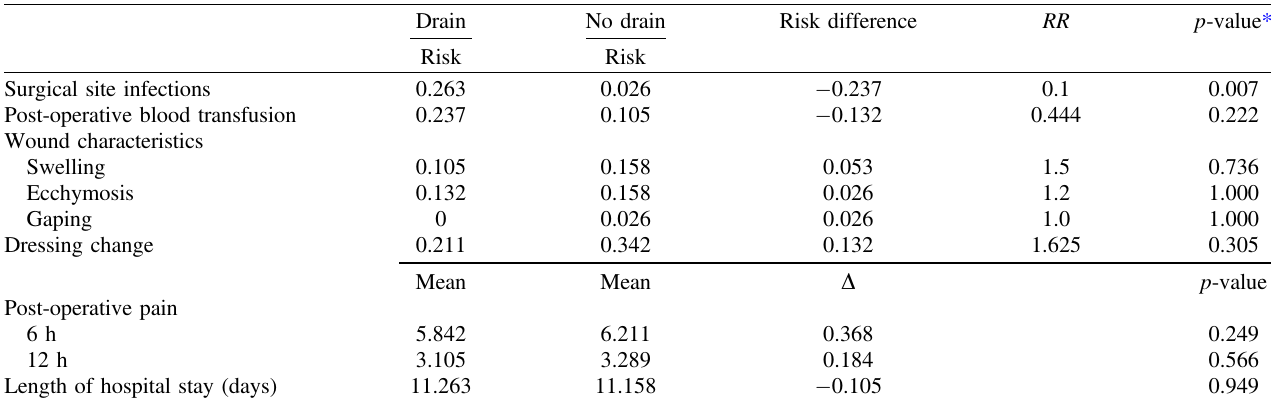
Table 2. Primary and secondary outcomes by prophylactic surgical drain vs. no